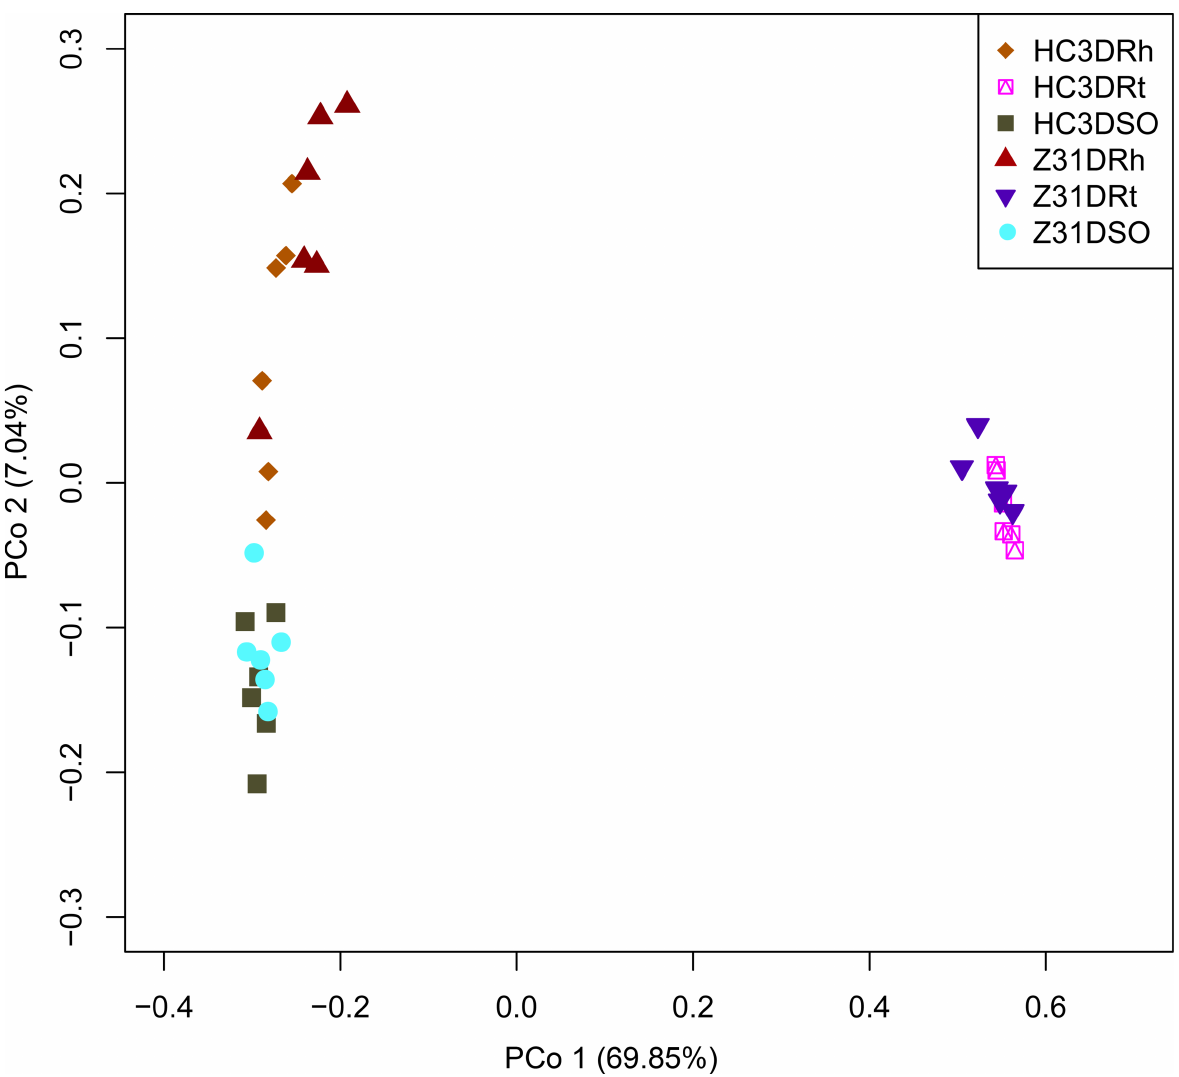
Fig 3. PCoA based on the Bray–Curtis distance metrics of root-associated bacterial communities between Z31 and HC3 at the seed-filling stage (n = 36). HC3DRt and Z31DRt represent the roots of the recipient cultivar HC3 and the transgenic line Z31 at the seed-filling stage, respectively. HC3DRh and Z31DRh represent the rhizospheric soils of the recipient cultivar HC3 and the transgenic line Z31 at the seed-filling stage, respectively. HC3DSO and Z31DSO represent the surrounding soils of the recipient cultivar HC3 and the transgenic line Z31 at the seed- filling stage,